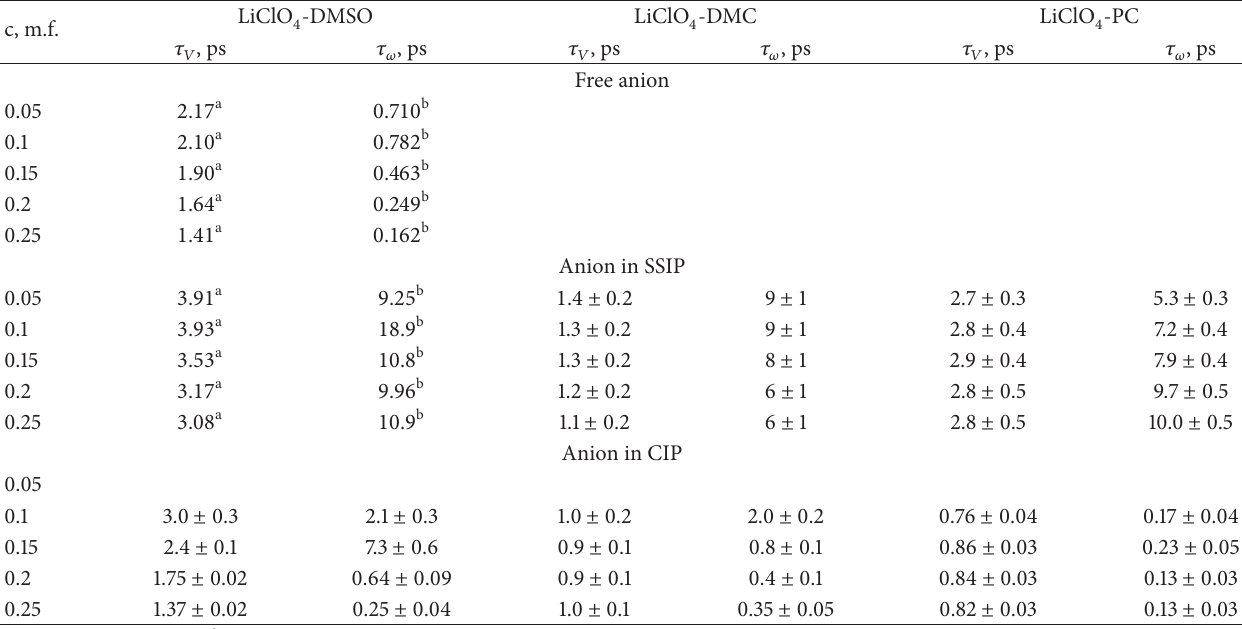
Table 4: Relaxation 𝜏 𝑉 and modulation 𝜏 𝜔 times for Cl-O vibrations of ClO 4− anion in ionic solutions of DMSO, PC and DMC. c, m.f.